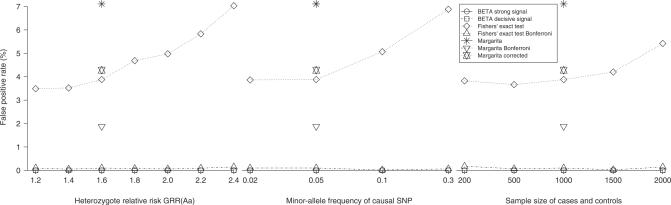
Mean False-Positive Rates (%) for Various ModelsEach point on the x-axis corresponds to 50 datasets under each of the simulation parameters while keeping the rest at their default values. The three points that do not belong to a line correspond to the default scenario for Margarita markerwise p-values calculated by permutation with or without Bonferroni correction, and Margarita experimentwise p-values calculated by permutation.